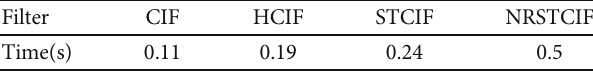
Table 1: Computational time comparisons.